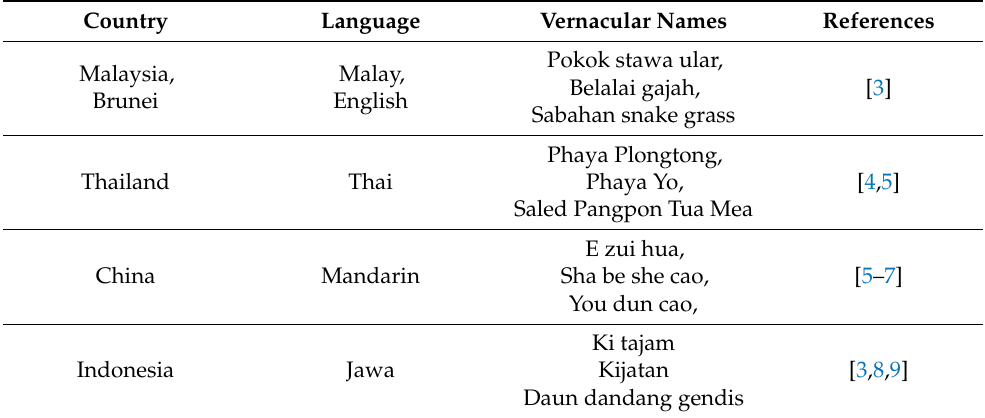
Table 1. Common vernacular names of C. nutans .